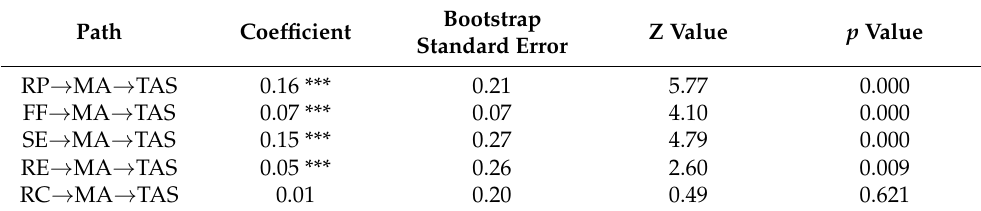
Table 9. Indirect or mediation effects by